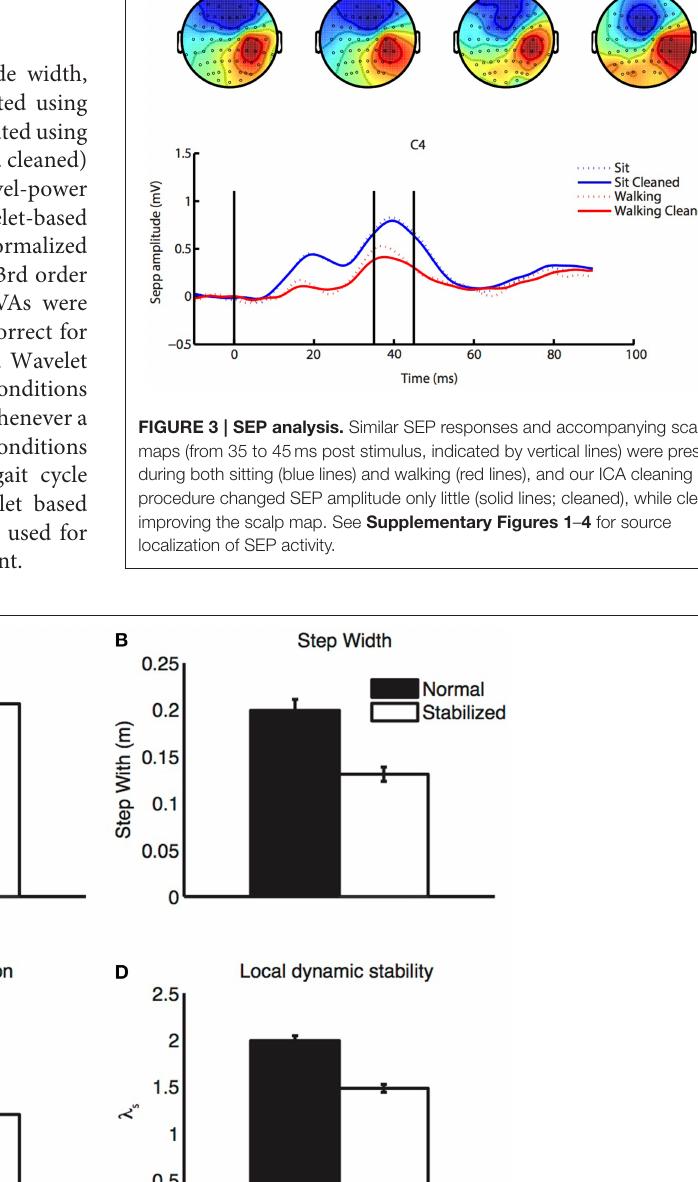
Frontiers in Human Neuroscience |